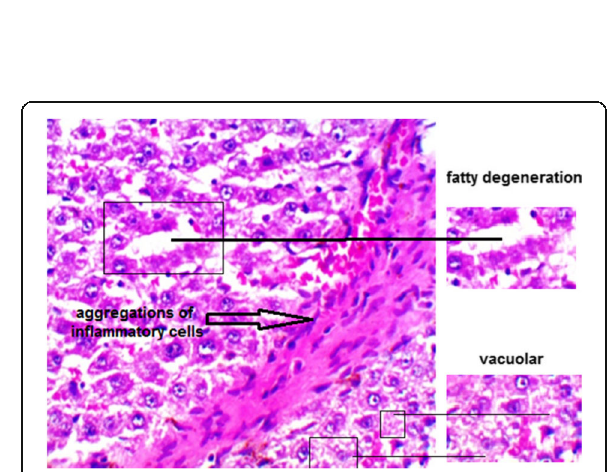
Fig. 2 Photomicrograph of the control liver showing cords of hepatocytes radiating from the central vein and separated by blood sinusoids (H&E; × 200)